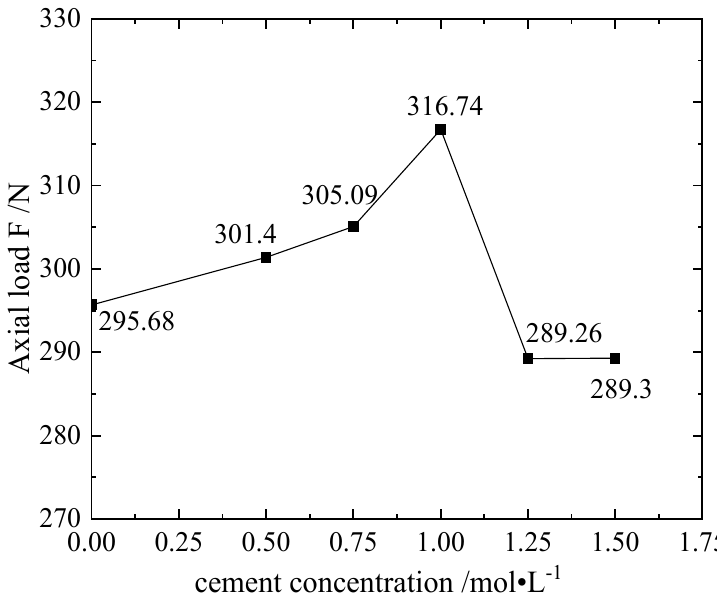
Figure 6. Sample of E scheme: F diagram of cementation solution concentration and axial load.